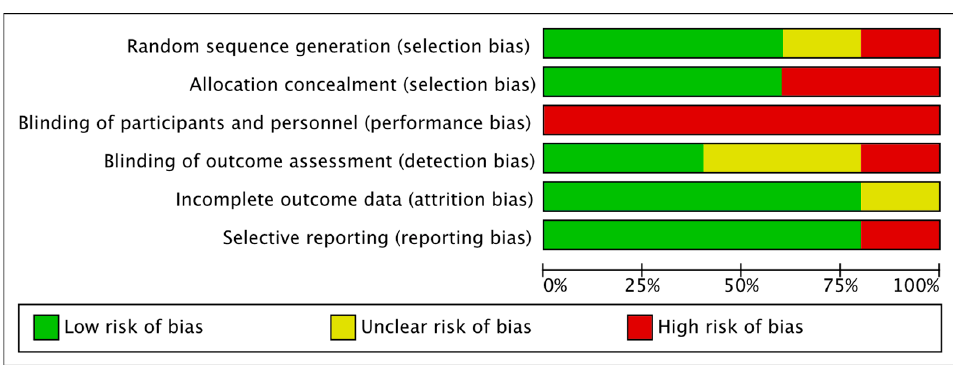
Figure 2. Risk of bias of the studies included in the systematic review [36–40].